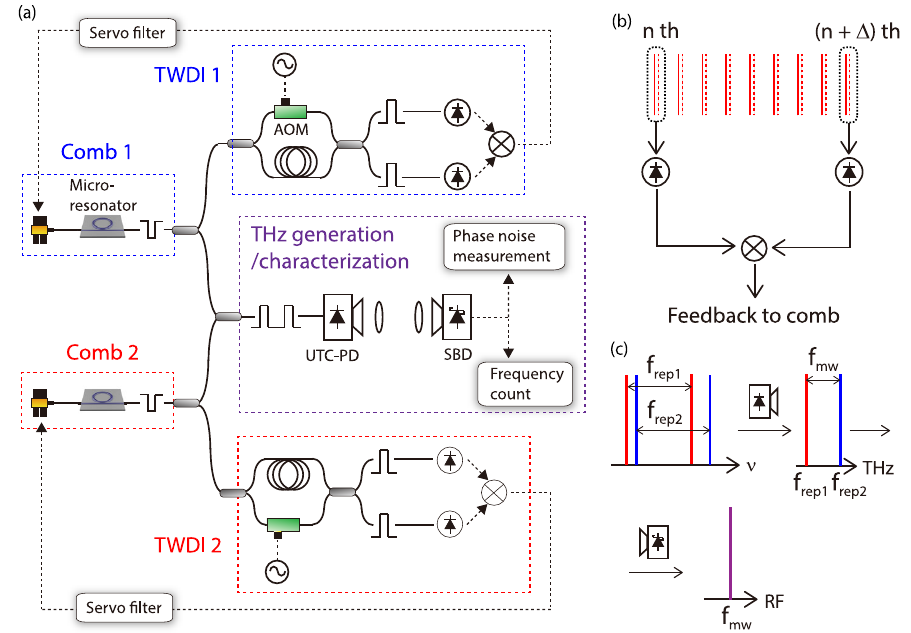
Fig. 2 Low phase noise THz genearation and characterization. a Schematic of the experimental setup. The dashed blue (red) squares show the setups for comb 1 (comb 2) and TWDI 1 (TWDI 2). The dashed purple squares show the setup for the generation and characterization of a THz wave. AOM: acousto- optic modulator, SBD: Schottky barrier diode. b Illustration of the working principle of the TWDI. Pairs of single comb modes with (solid line) and without (dotted line) delay are photodetected, generating signals with the phase noise PSDs of ∣ H ( if ) ∣ 2 { L ceo ( f ) + n 2 L rep ( f )} and ∣ H ( if ) ∣ 2 { L ceo ( f ) + ( n + Δ ) 2 L rep ( f )}. By mixing the two signals, a DC signal with the phase noise PSD of ∣ H ( if ) ∣ 2 ⋅ Δ 2 L rep ( f ) is generated, which is used as an error signal. c Illustration of the working principle of the characterization of the phase noise of the THz. Four comb modes from combs 1 and 2 are directed into an UTC-PD, generating two THz waves with the carrier frequencies of f rep1 and f rep2 . The two THz waves are squared-law-detected at a SBD, generating a microwave with the phase noise of the sum of the two THz